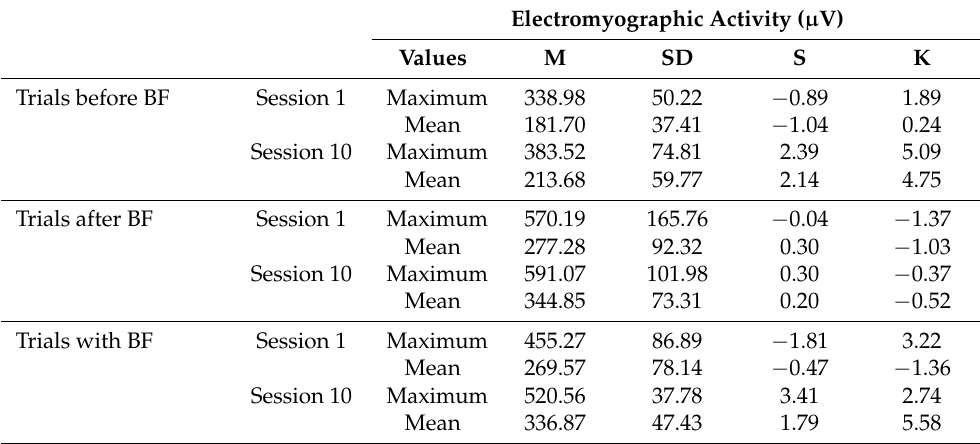
Table 4. Descriptive statistics for maximum and mean values of electromyographic activity for trials before and after the application of BF, and also for trials with BF in sessions 1 and 10.